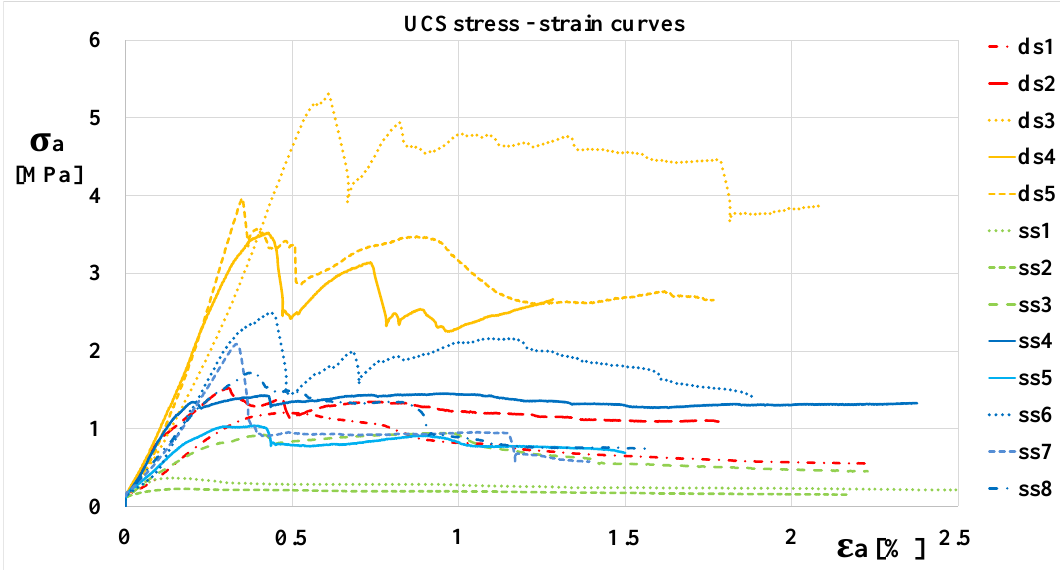
Figure 4. Uniaxial compressive strength (UCS) stress-strain curves for calcarenite/calcisiltite rock (σ a : Uniaxial compressive strength; ε a : Axial strain). Yellow curves: Calcarenite dry samples; blue curves: Calcarenite saturated samples; red curves: Calcisiltite dry samples; green curves: Calcisiltite saturated samples.